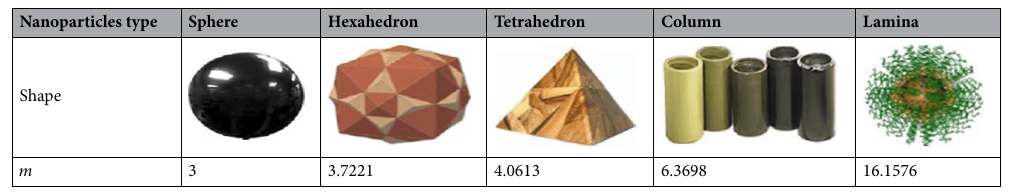
Table 2. Empirical form factor values for various particle